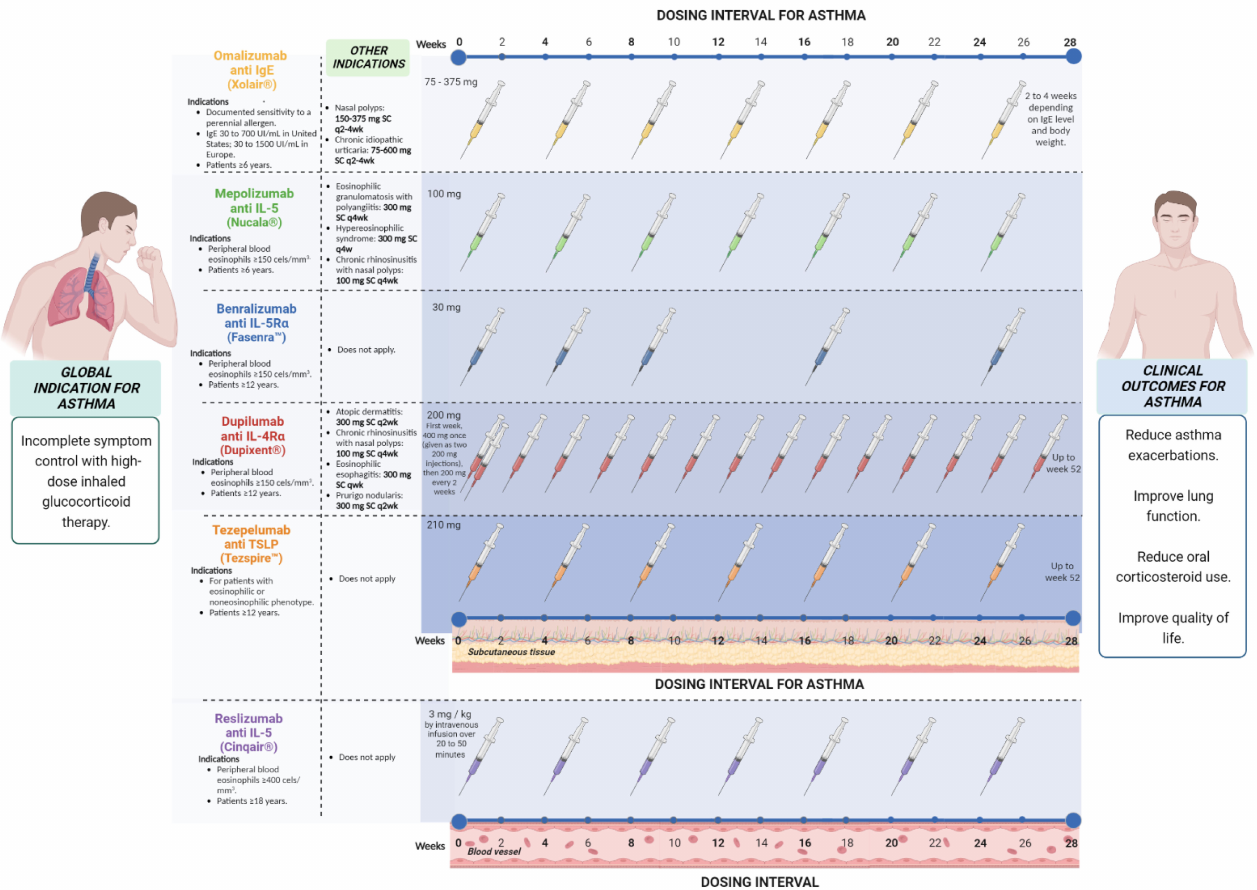
Figure 2. Doses and eligibility criteria of targeted therapy that has been approved for